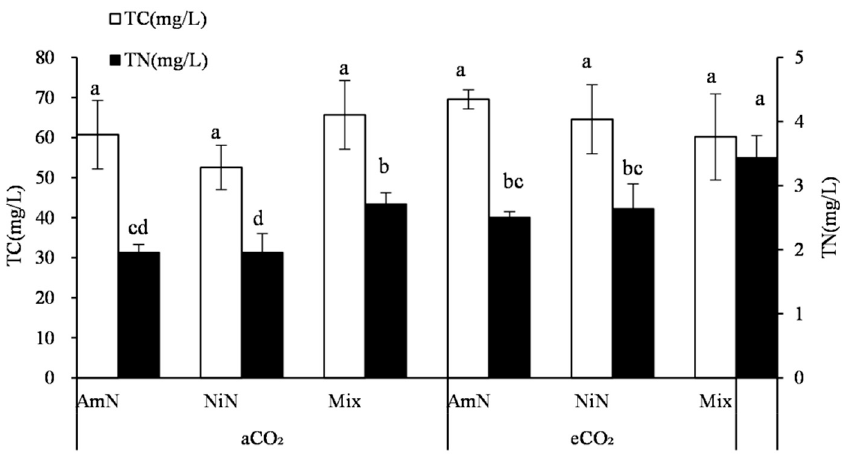
Figure 4. Carbon and nitrogen concentrations in root exudates of maize. Note: (1) AmN denotes Ammonium N, NiN denotes Nitrate N, Mix denotes Mixed N; (2) TC means total C concentration, TN means total N concentration; (3) aCO 2 denotes the ambient atmospheric CO 2 concentration at 390 µ mol/mol; eCO 2 denotes the enriched atmospheric CO 2 concentration at 690 µ mol/mol; (4) Different letters mean significant differences at p < 0.05 level for each indice; (5) error bars are standard deviation; (6) Statistical analyses for TC and TN LSD are conducted separately. Table 7. Maize Two − factor ANOVA analyses for indices in the root exudate of wheat. Maize TC TN CO 2